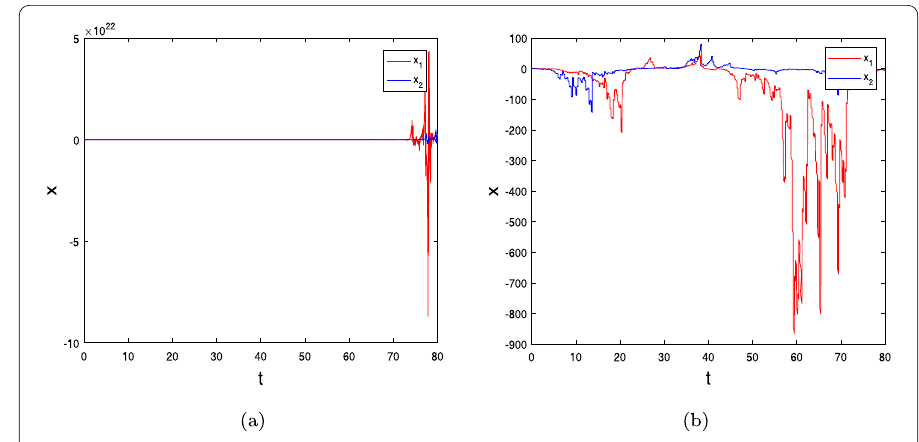
Figure 3 The left curve shows an unstable trajectory of X ( t ) generated by the EM scheme for system (28) by continuous noise with time delay τ = 0.12, while the right one shows an unstable trajectory for system (28) by